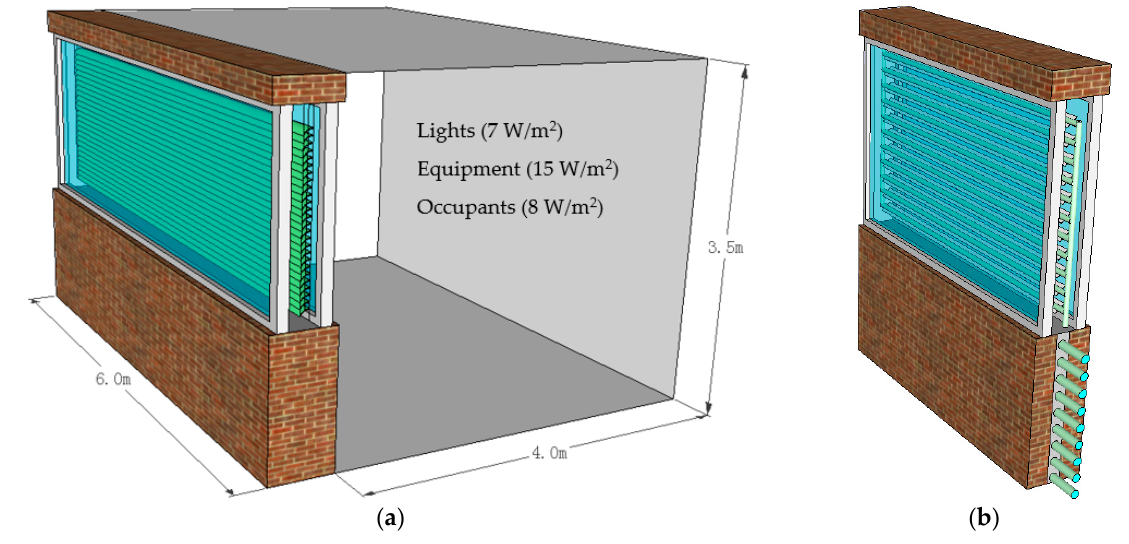
Figure 2. Configuration of the simulated office: ( a ) Office with traditional envelope; and ( b ) Synthetic pipe-embedded envelope.